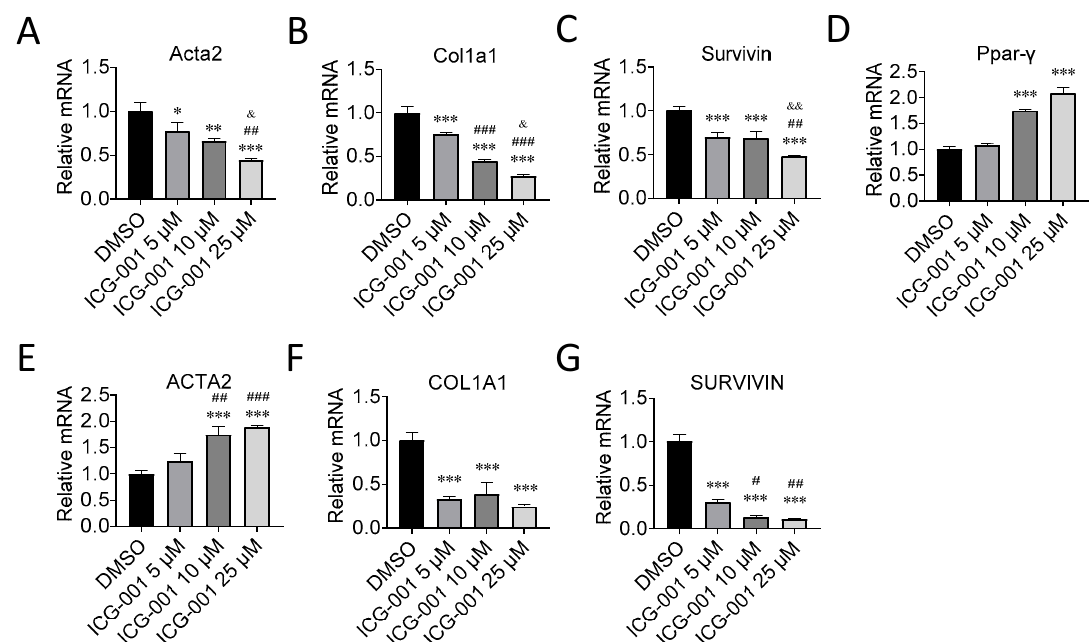
Figure 2. CBP/ β -catenin antagonism suppresses gene expression of activation markers of pancreatic stellate cells. Effect of CBP/ β -catenin antagonist ICG-001 versus control (DMSO) treatment for 48 h of immortalized mouse pancreatic stellate cells (imPSC) on mRNA expression of activation markers, Acta2 ( A ); Col1a1 ( B ); Survivin ( C ); and Ppar- γ which is associated with quiescence ( D ). Effect of ICG-001 treatment for 48 h of immortalized human pancreatic stellate cells (ihPSC) on mRNA expression of activation markers, ACTA2 ( E ); COL1A1 ( F ); and SURVIVIN ( G ). n = 3, * p < 0.05, ** p < 0.01, *** p < 0.001 compared to control (DMSO), # p < 0.05, ## p < 0.01, ### p < 0.001 compared to ICG-001 5 μ M, &